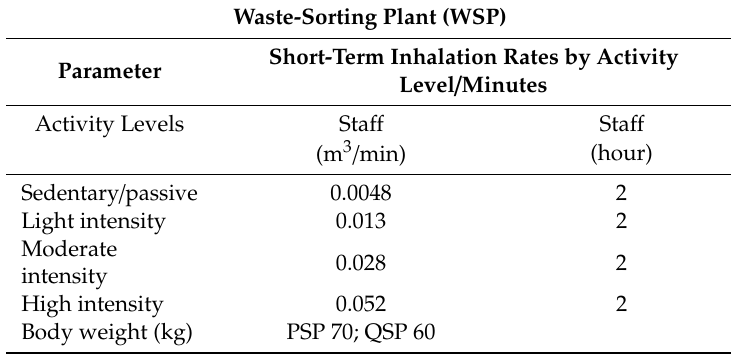
Table 2. Description of the time budget and exposure (EX) dose for workers in the two WSP cabins (PSP and QSP).